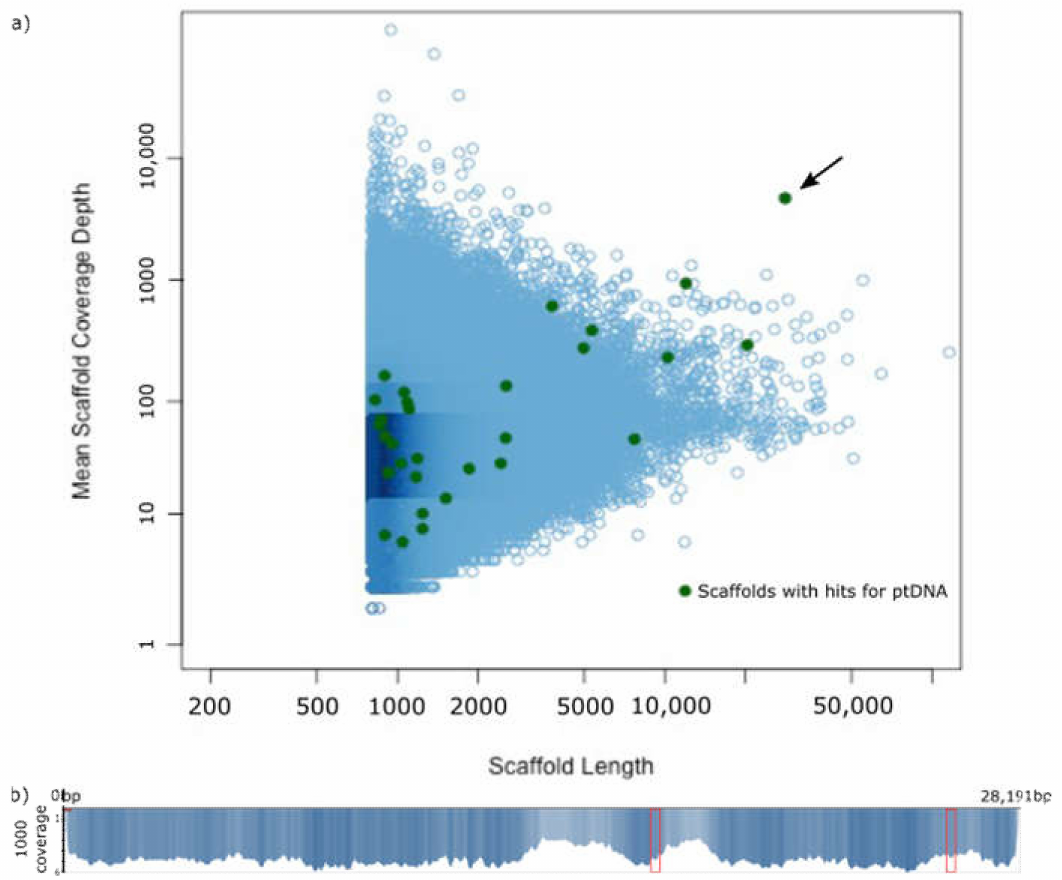
Figure 1. The plastid genome of Prosopanche americana is found on a single sca ff old. a ) Stoichiometry plot of the sca ff old lengths and the respective mean coverage depth of the Prosopanche americana assembly. Sca ff olds are visualized as blue circles. The green dots represent sca ff olds with BLAST hits for annotated fractions of the plastome (derived from “gene features” in NCBI). The black arrow points to sca ff old 424. b ) Distribution of the reads mapped to the linear sca ff old 424 with the scale displaying the depth of coverage in 1k increments. The red boxes represent the coverage of the Prosopanche amercana repeat